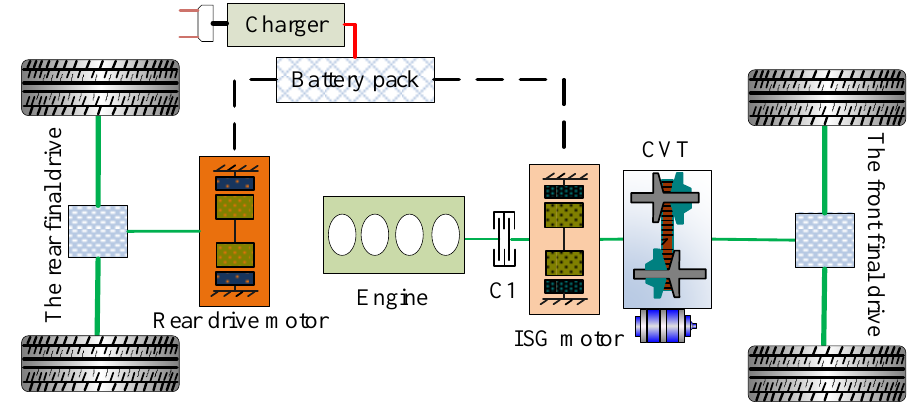
Figure 1. The plug-in 4-wheel drive (4WD) hybrid electric vehicle powertrain.